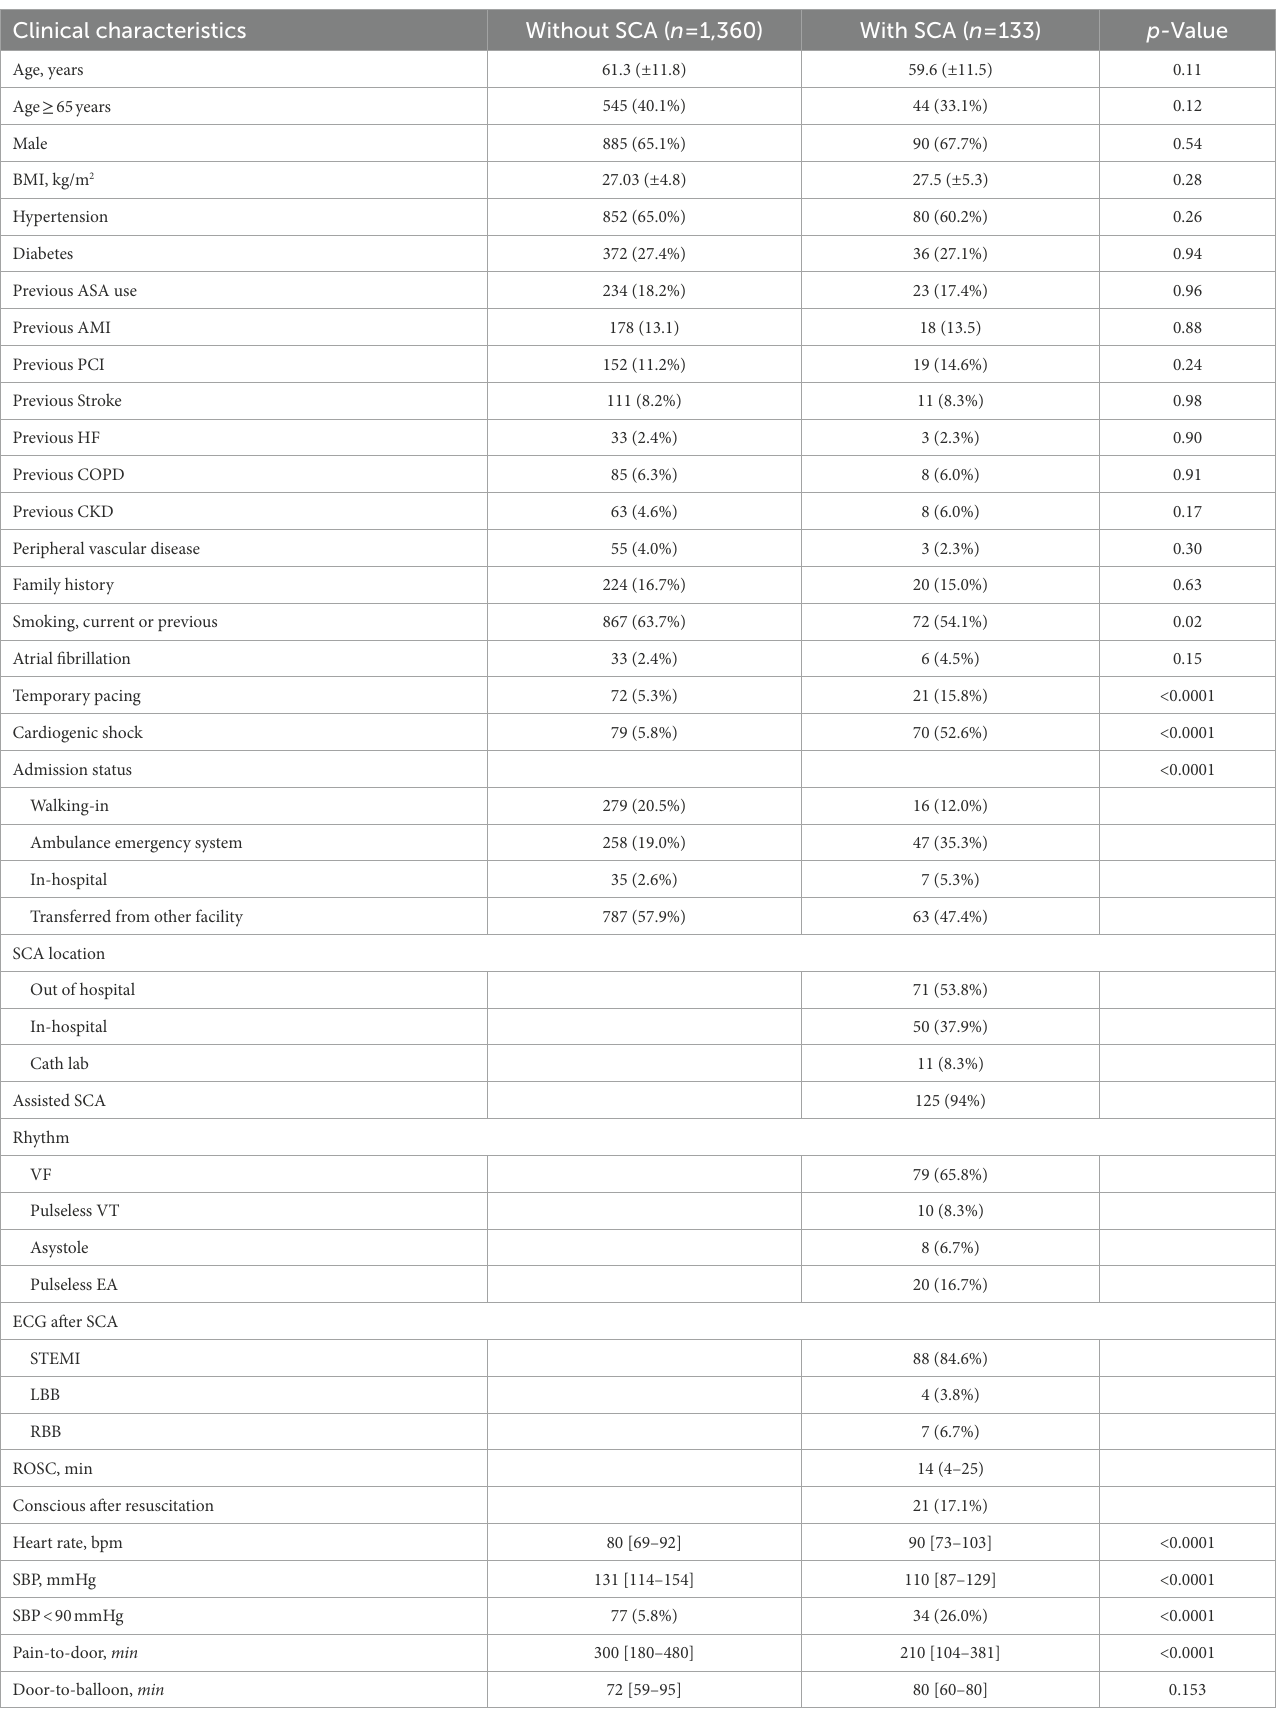
TABLE 1 Baseline characteristics of study patients. Clinical